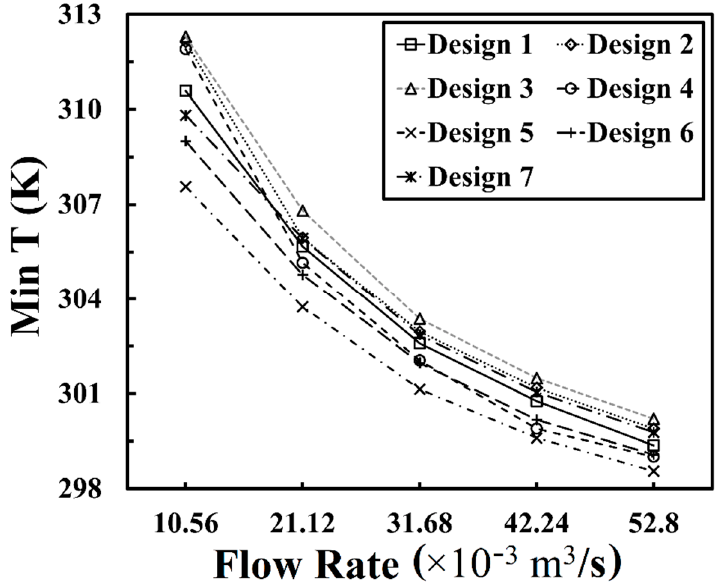
Figure 7. Minimum temperatures of 7 designs at 5 flow rates.